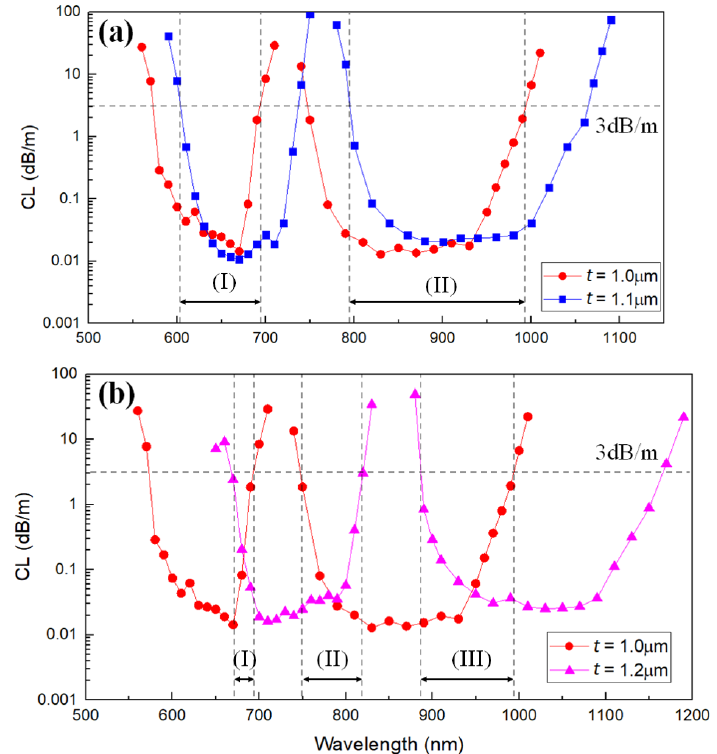
Figure 2. Simulated second and third transmission bands of HC-ARFs with different t . Roman numerals mark the hybrid transmission bands of HC-ARFs with: ( a ) t = 1.0 µ m and t = 1.1 µ m; ( b ) t = 1.0 µ m and t = 1.2 µ m. In all cases, D = 30.0 µ m, p = 24.0 µ